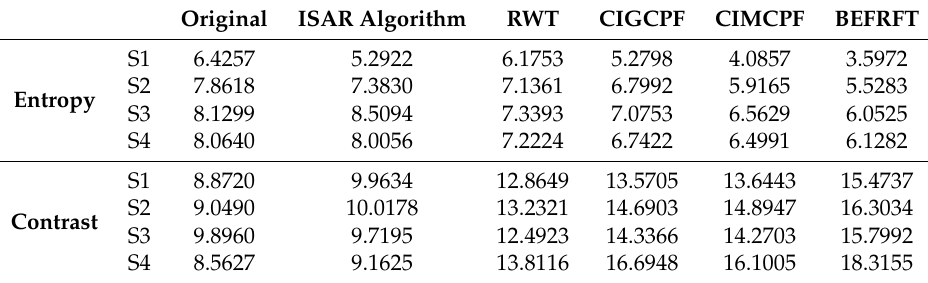
Table 3. Entropies and contrasts of ship